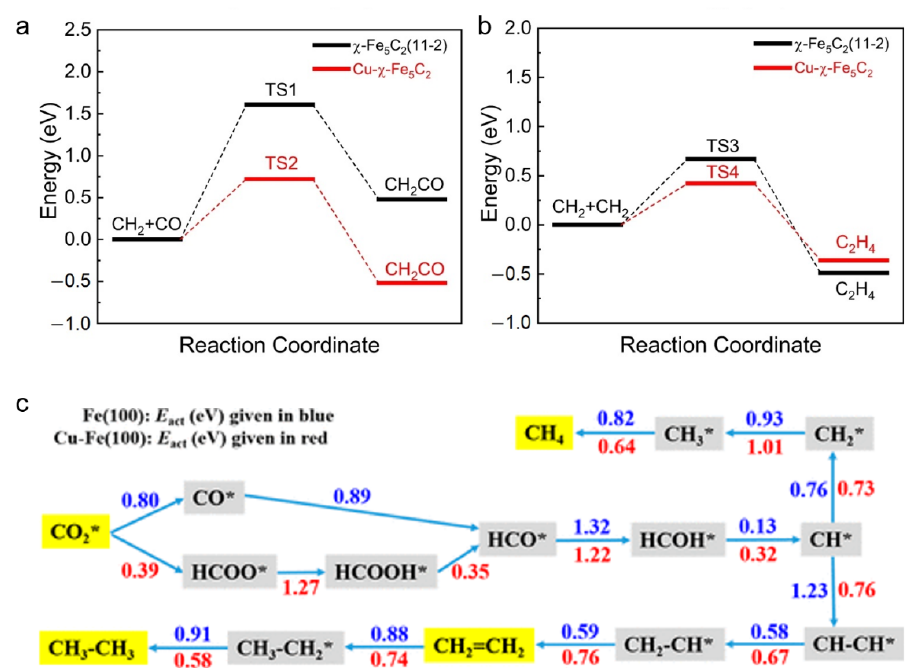
Figure 6. ( a ) Comparison of energy barriers of CH 2 + CO over Cu- χ -Fe 5 C 2 and χ -Fe 5 C 2 (11-2) facets; ( b ) comparison of energy barriers of CH 2 + CH 2 over Cu- χ -Fe 5 C 2 and χ -Fe 5 C 2 (11-2) facets. Reprinted with permission from ref. [78] . Copyright 2022 Springer. ( c ) Reaction pathways for production of CH 4 , C 2 H 4 and C 2 H 6 from CO 2 on Fe(100) and the Cu–Fe(100) surface at 4/9 ML coverage. Kinetic barrier for each elementary step is given in eV. Reprinted with permission from ref. [105]. Copyright 2017 American Chemical Society.